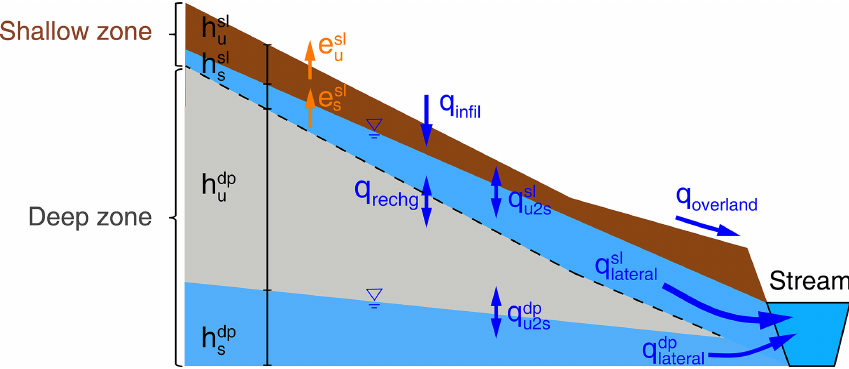
Figure 2. Hillslope view of the shallow and deep zones and relevant water flows. Streams received water primarily from three water flows: ) , and the lateral flow that has been recharged and eventually come the surface runoff (q overland ) , lateral flow from the shallow zone (q sl lateral ) . The symbols “ h ”, “ e ”, and “ q ” denote water storage, evapotranspiration, and water flow, respectively. out from the deeper zone (q dp lateral The superscript letters “sl” and “dp” refer to shallow and deep zones, respectively. The subscript letters “u” and “s” refer to unsaturated and saturated layers, respectively. Detailed equations are in Sect. 3.1 and 3.2. The terms “infil”, “u2s”, and “recharge” refer to infiltration, unsaturated to saturated zones, and